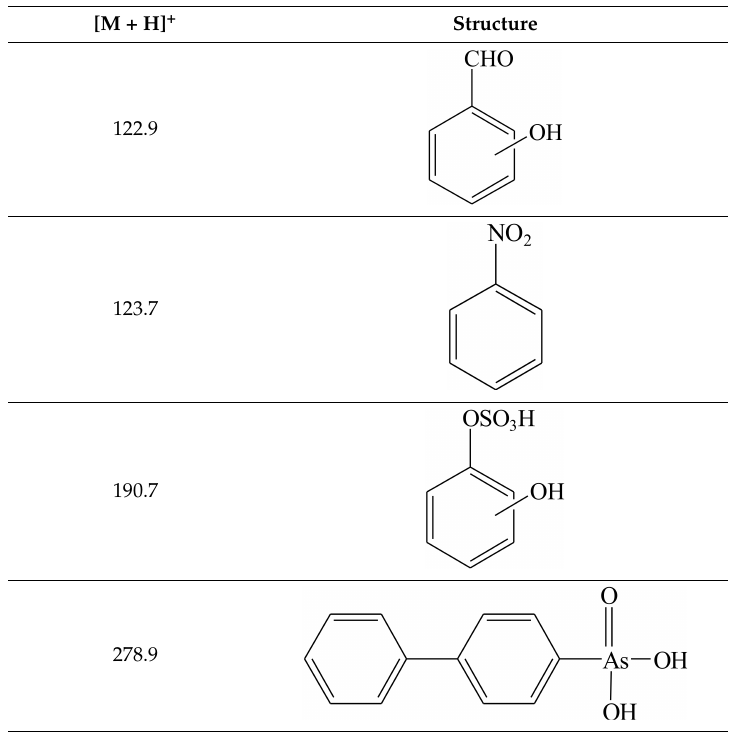
Table 1. The photooxidation products during UV-C irradiation identified by LC-MS.